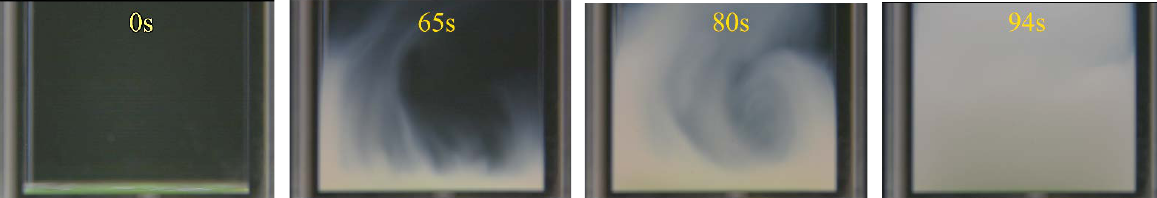
Figure 1. Acoustic wave energy absorption (turbidity) mechanism during the imposing 2.5 MHz and 30 mV ultrasonic actuation of the 1 wt% microgel solution.